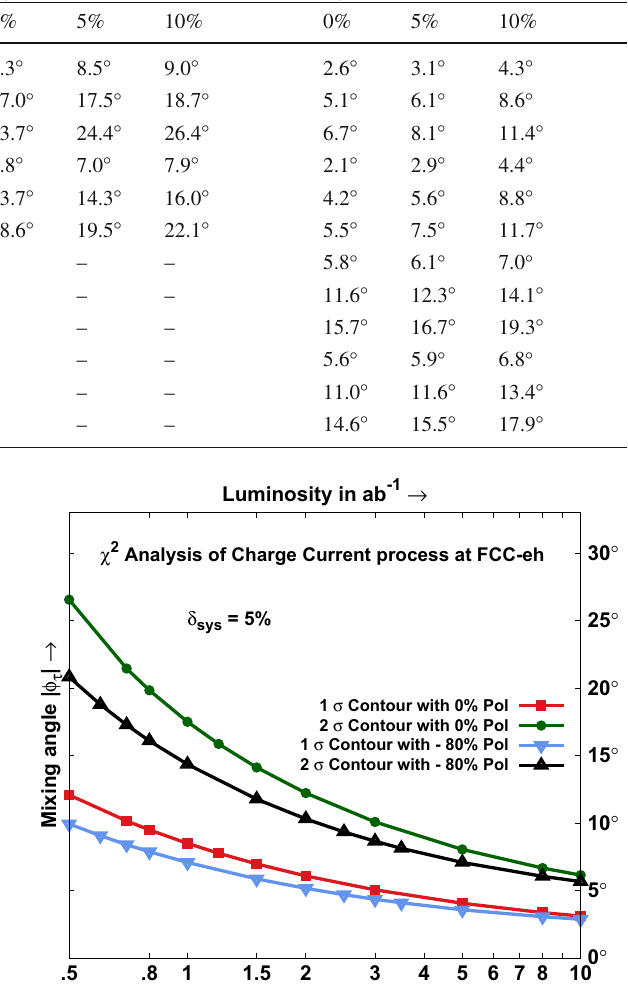
Fig. 6 χ 2 contours are drawn in luminosity – lower limit on the Mix- ing angle plane for unpolarised ( − 80% polarised) corresponding to the contribution from charged current process in the FCC − eh setup with δ = sys